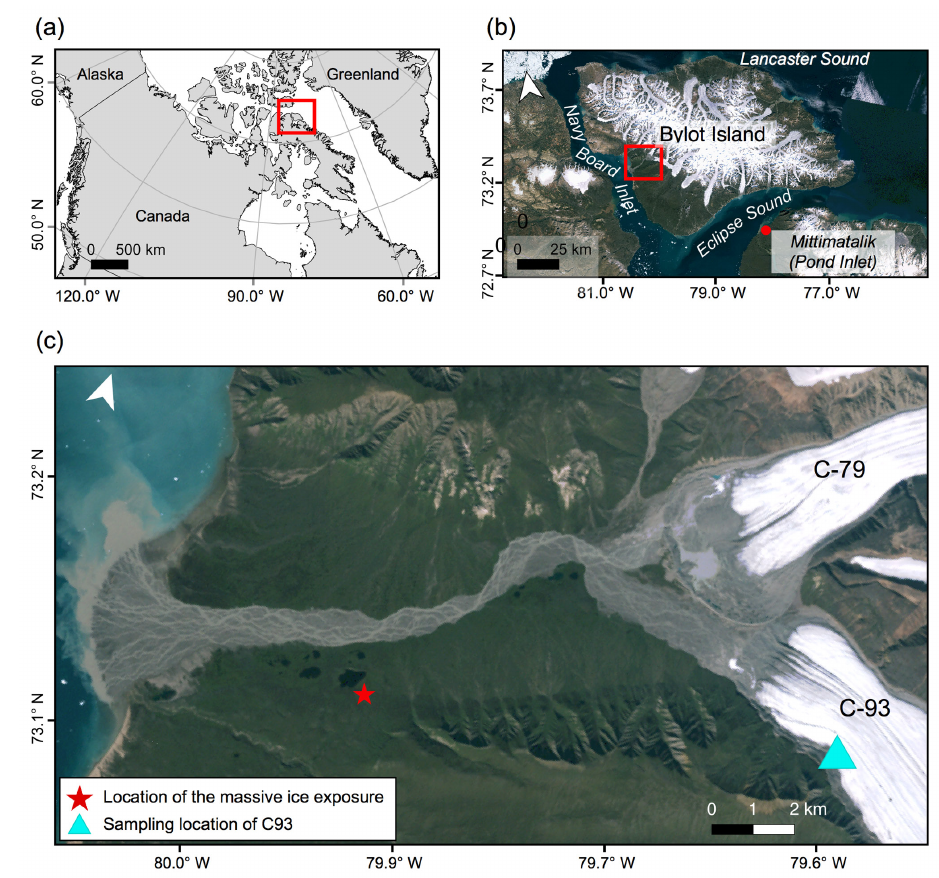
Figure 1. (a) Location of Bylot Island, (b) location of the Qarlikturvik valley, (c) location of the study area within the Qarlikturvik Valley (valley of glaciers C-79 and C-93), Bylot Island, Nunavut, Canada. Wedge ice, segregated ice and snow were also sampled near ( < 1km) the massive ice exposure. The thaw depths were measured with a steel probe at every 10m along a 150m